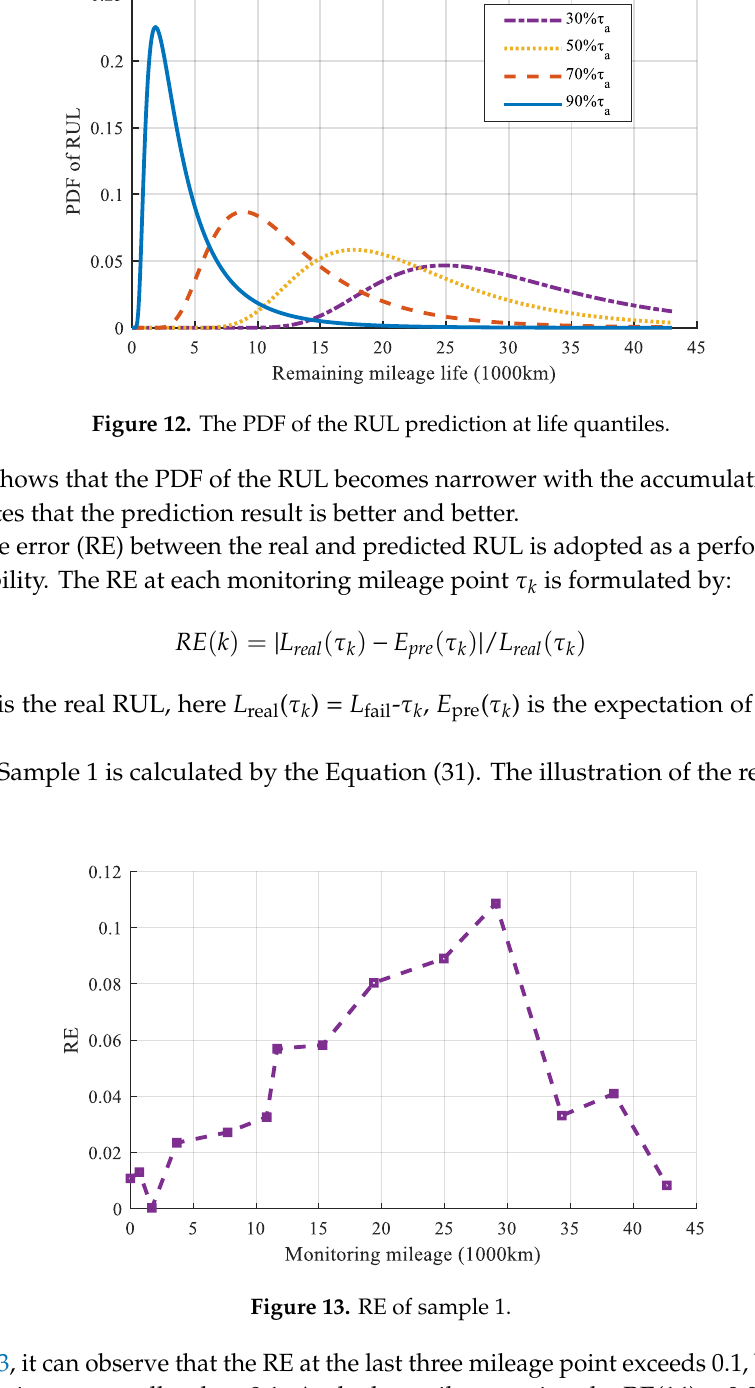
Figure 13. RE of sample 1.